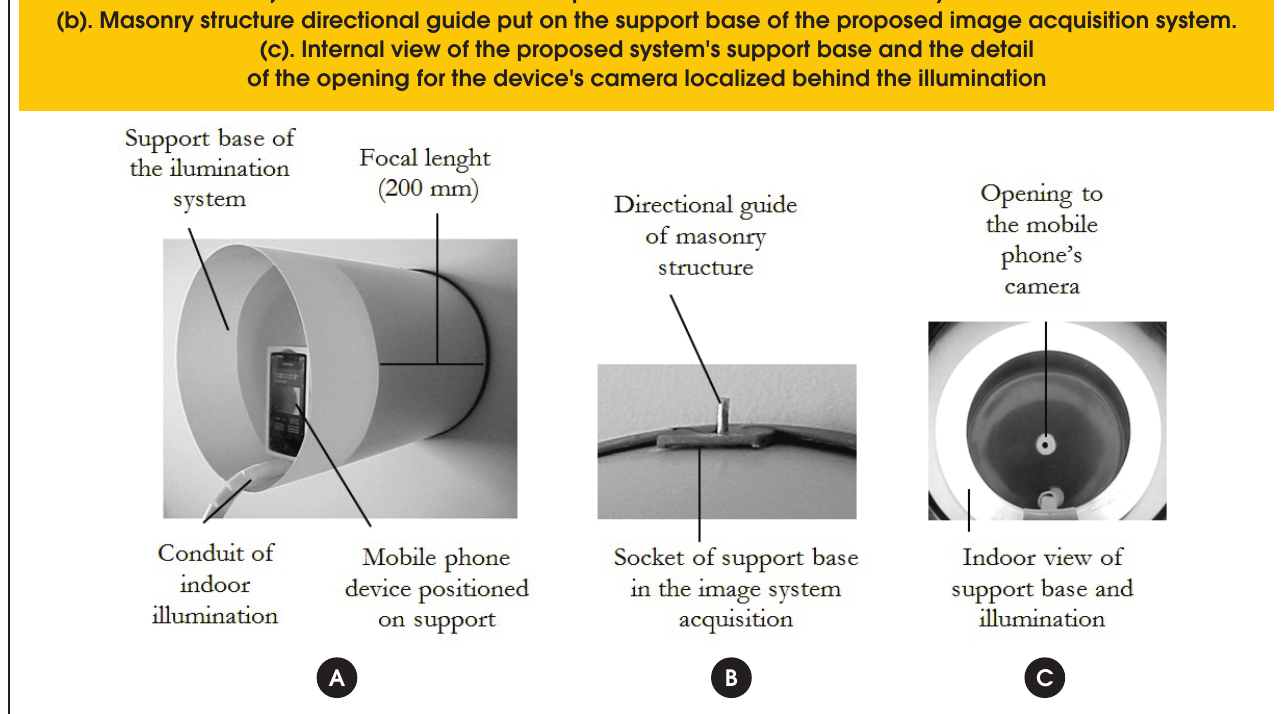
Figure 4 – Image acquisition of the proposed vision system. (a). mobile phone positioned on the support base on a masonry structure. In this case a 200 mm focal length was adjusted between the mobile phone's camera and the masonry